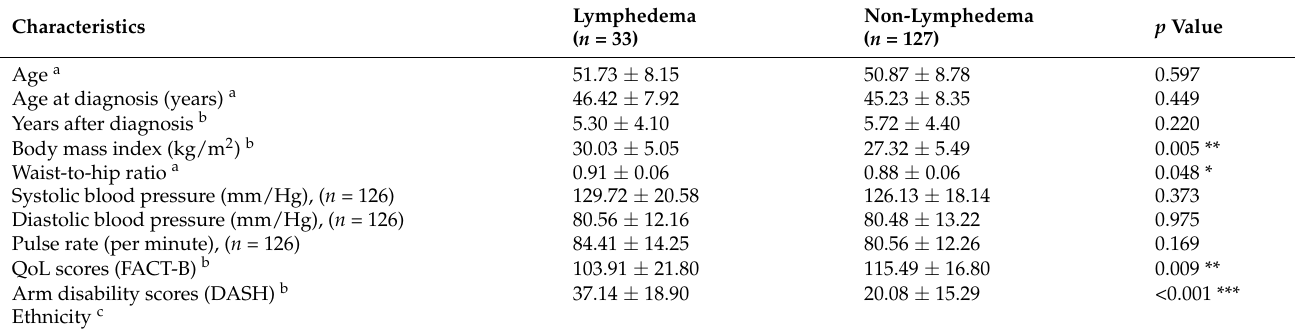
Table 1. Baseline characteristics of breast cancer survivors with and without lymphedema reported at recruitment (N = 160).